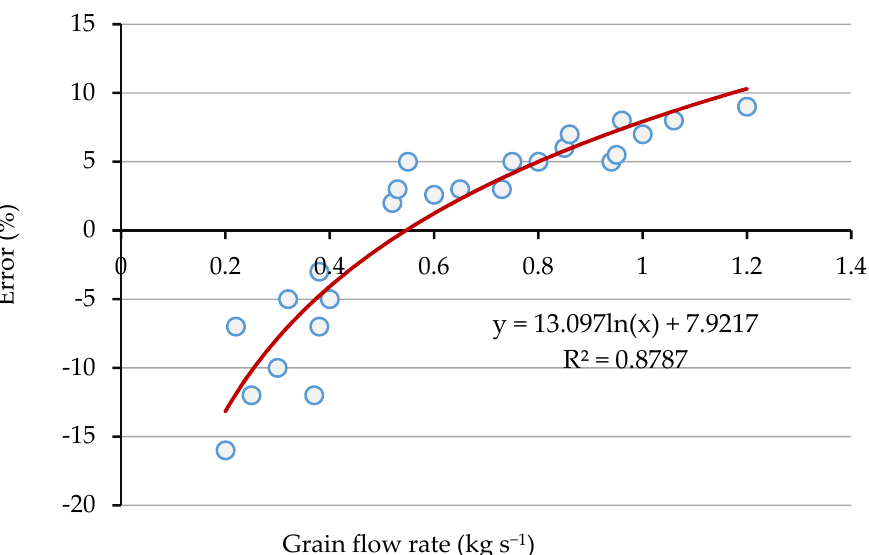
Figure 6. Errors between actual cumulative weights and yield meter cumulative weights.